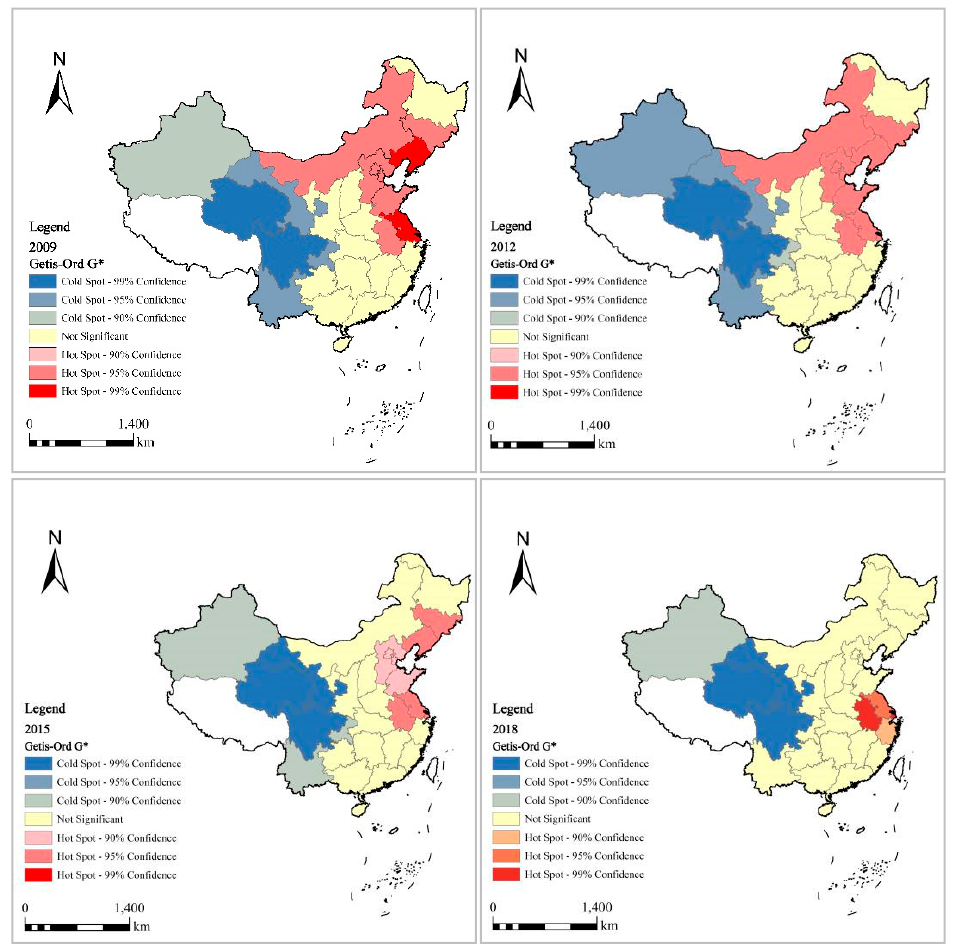
Figure 3. China’s cold versus hot spot spatial evolution on coordination degree in regard to carbon emissions, economic development, and environmental protection.